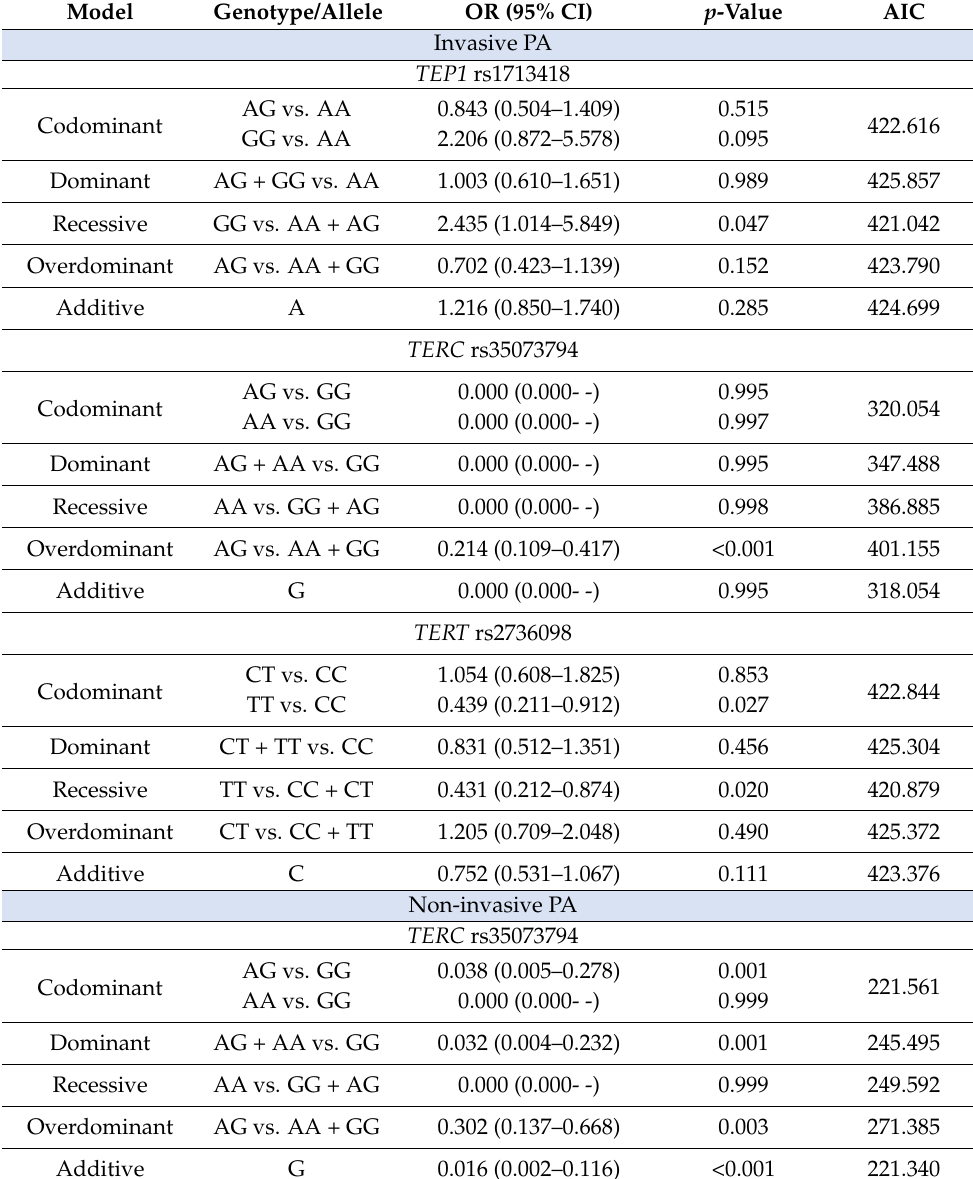
Table 7. Binary logistic regression analysis within invasive or non-invasive PA and control group